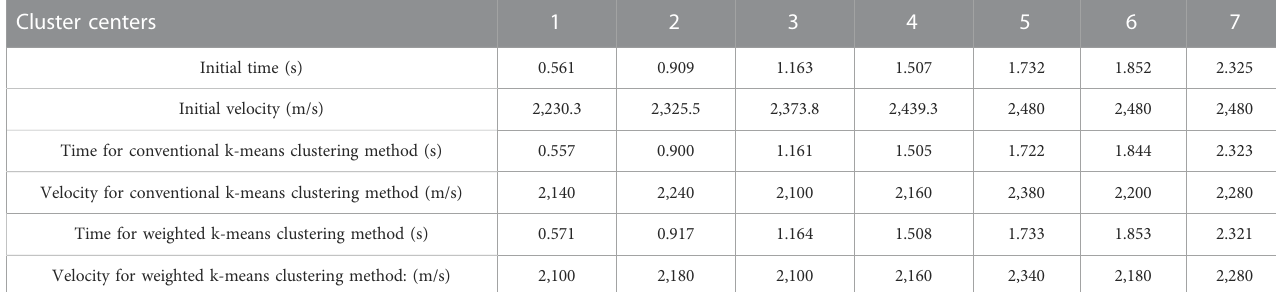
TABLE 2 Initial values and picking results for the cluster centers. Cluster centers